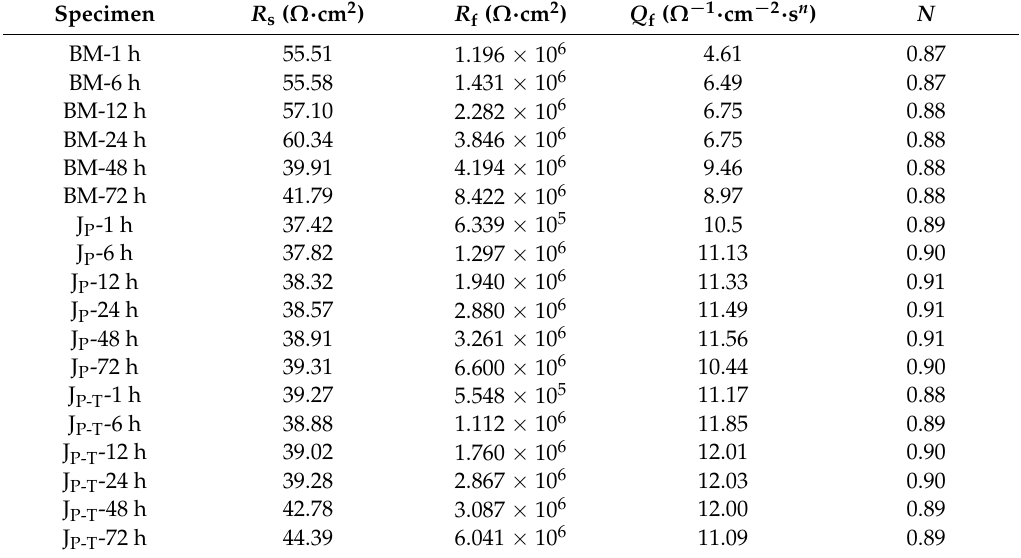
Table 4. Fitting EIS results for the BM, J P , and J P-T for different immersion times at OCP in 1 M NaCl